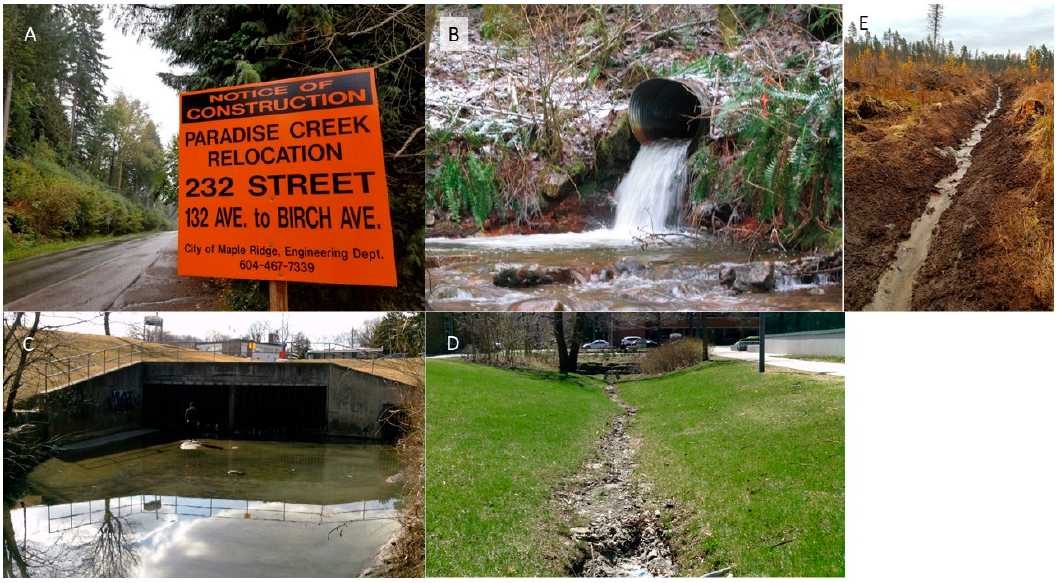
Figure 2. Examples of the adverse alterations of headwater streams: ( A ) A notice of a creek being “relocated” to enable development in British Columbia, Canada (October 2017); ( B ) a culvert at a road crossing in British Columbia; ( C ) the origin of Wilket Creek, part of the West Don River in Toronto, Canada emerging from its subterranean network now mostly in storm drains (note the person standing in front of the opening); ( D ) an ephemeral stream in Toronto with a mowed lawn to its edge; ( E ) a headwater stream converted to a ditch near Umeå, Sweden. Figure 2C and D are courtesy of Brian Kielstra, the University of British Columbia, and Figure 2E is courtesy of Lenka Kuglerová, Swedish Agricultural University.